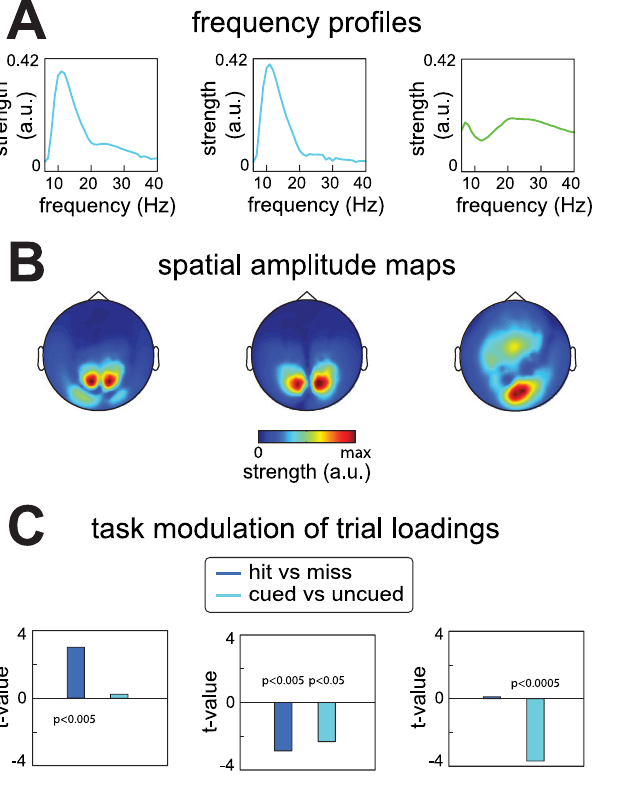
Fig 7. Task modulation of neuronal activity revealed by the trial profile of components extracted from the representative subject. Components reflect neuronal sources, and their strength in each trial is quantified by a single number, combined into the trial profile. These trial-level quantifications can be used to analyze neuronal activity as a function of the task at the level of components. We demonstrate this in three components from the representative subject. The three components were selected out of the 15 because they showed the strongest effects, and reflected two posterior alpha components, and one occipito-central/ frontal beta component. A , frequency profiles of the selected components. B , spatial amplitude maps of the selected components. C , task-dependent activity of the components reflected by the contrasts expressed as t-values of independent samples t-tests. The first posterior alpha component was more active on hit trials then it was on miss trials (t(179) = 3.01, p < 0.005), but did not differ as a function of attention (t(399) = -0.23, p > 0.8). The second posterior alpha component was less active on hit trials than on miss trials (t(179) = -2.87, p < 0.005), and was also less active on cued trials than on uncued trials (t(399) = -2.31, p < 0.05). The beta component did not differ between hit and miss trials (t(179) = 0.12, p > 0.9) but was less active on cued than on uncued trials (t(399) = -3.69, p < 5 * 10^ -4